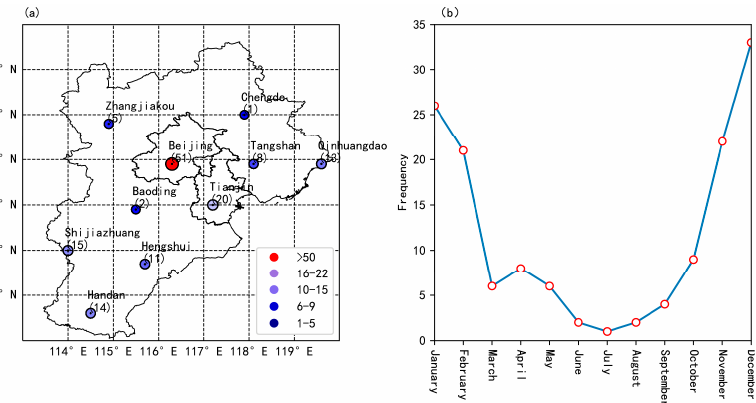
Figure 1. ( a ) Spatial distribution of annual total frequency of rail breakage (FRB) and ( b ) time series of monthly FRB of high-speed railway in Beijing–Tianjin–Hebei (BTH) region during 2010–2020. Since winter is the season with the highest FRB in BTH high-speed railway. The average FRB during winter is obtained to further analyze its spatial and temporal distribution pattern. The spatial distribution of winter FRB in BTH region is also very uneven (Figure 2a), with the maximum and sub-maximum values still occurring in Beijing and Tianjin with 32 and 16 breaks, respectively, while the minimum and sub-minimum values are still located in Chengde and Baoding with one and two breakages, respectively.